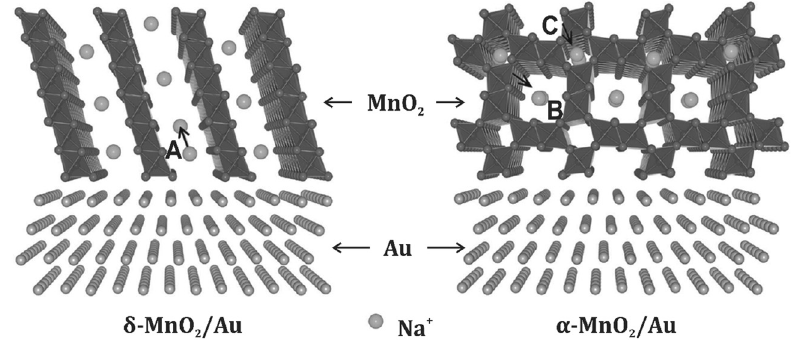
Figure 4: Di ff erences in the sizes of interatomic channels of the δ - MnO 2 and α - MnO 2 phases, and possible di ff usions of Na + ions in these channels [ 55 ] .